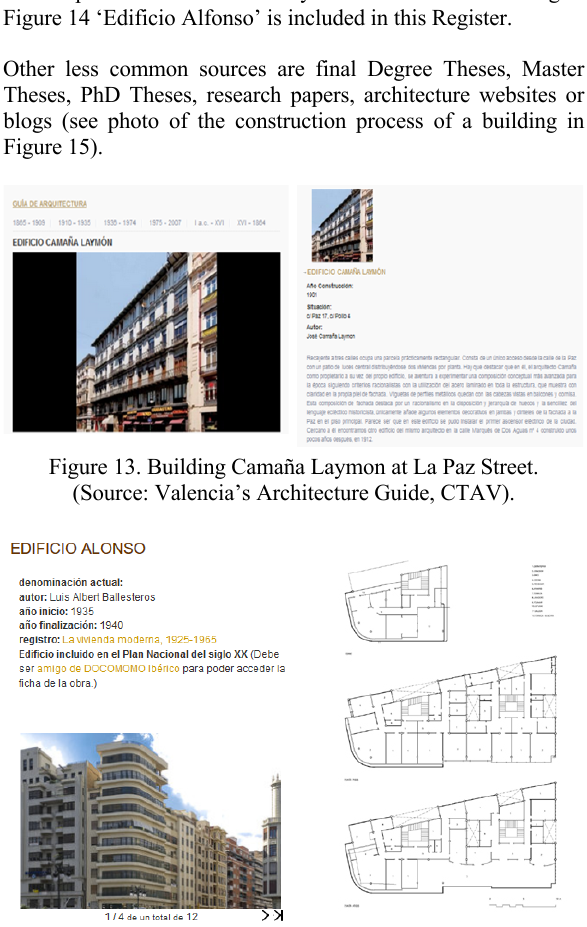
Figure 14. Building Alonso at S. Vicente Street.